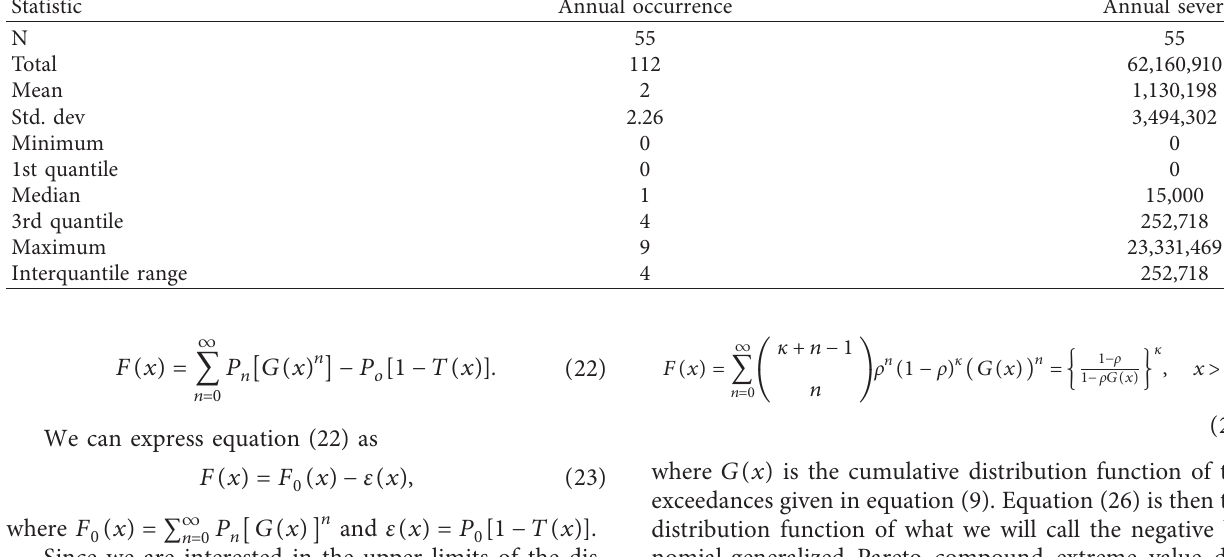
Table 1: Descriptive statistics of the occurrence and severity of natural disaster